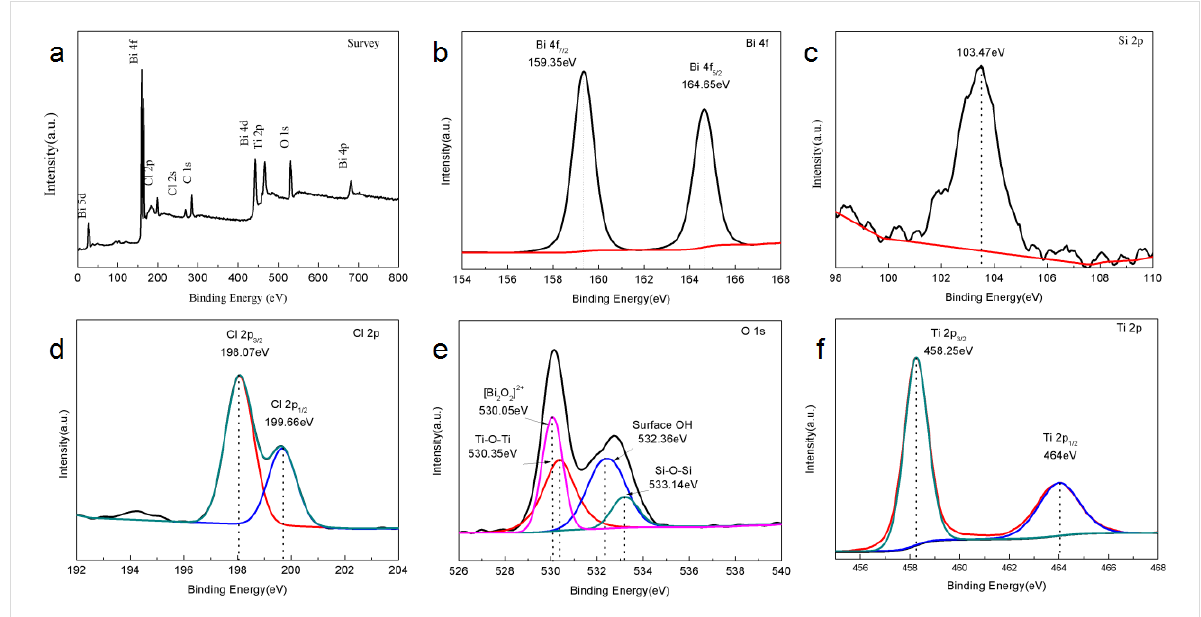
Figure 3: XPS spectra of BTD, including the survey scan (a) and detailed Bi 4f (b), Si 2p (c), Cl 2p (d), O 1s (e) and Ti 2p (f) spectra.